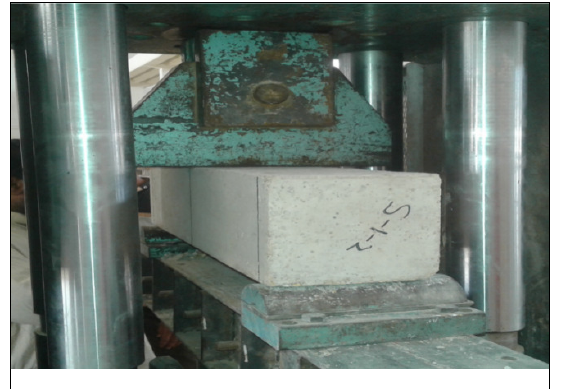
FIG. 4. AN OVERVIEW OF PRISM TESTING IN UTM FOR FLEXURAL STRENGTH